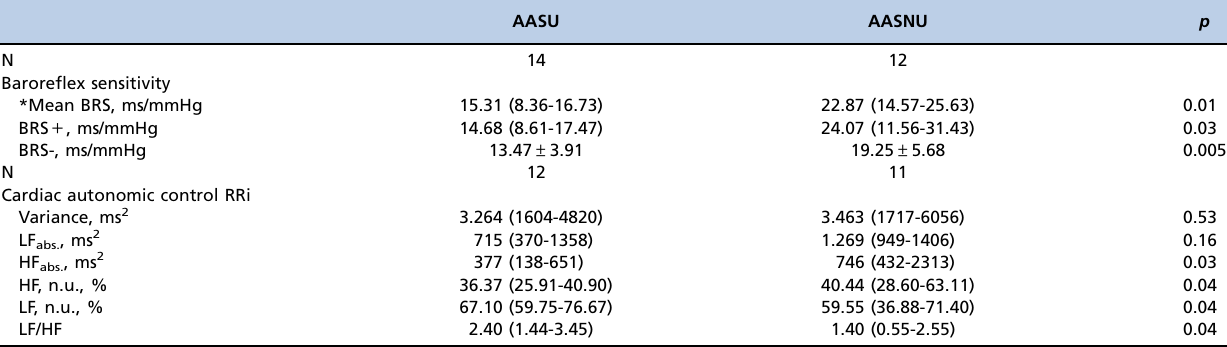
Table 2 - Spontaneous baroreflex sensitivity and cardiac autonomic control in anabolic androgenic steroid users and anabolic androgenic steroid nonusers.